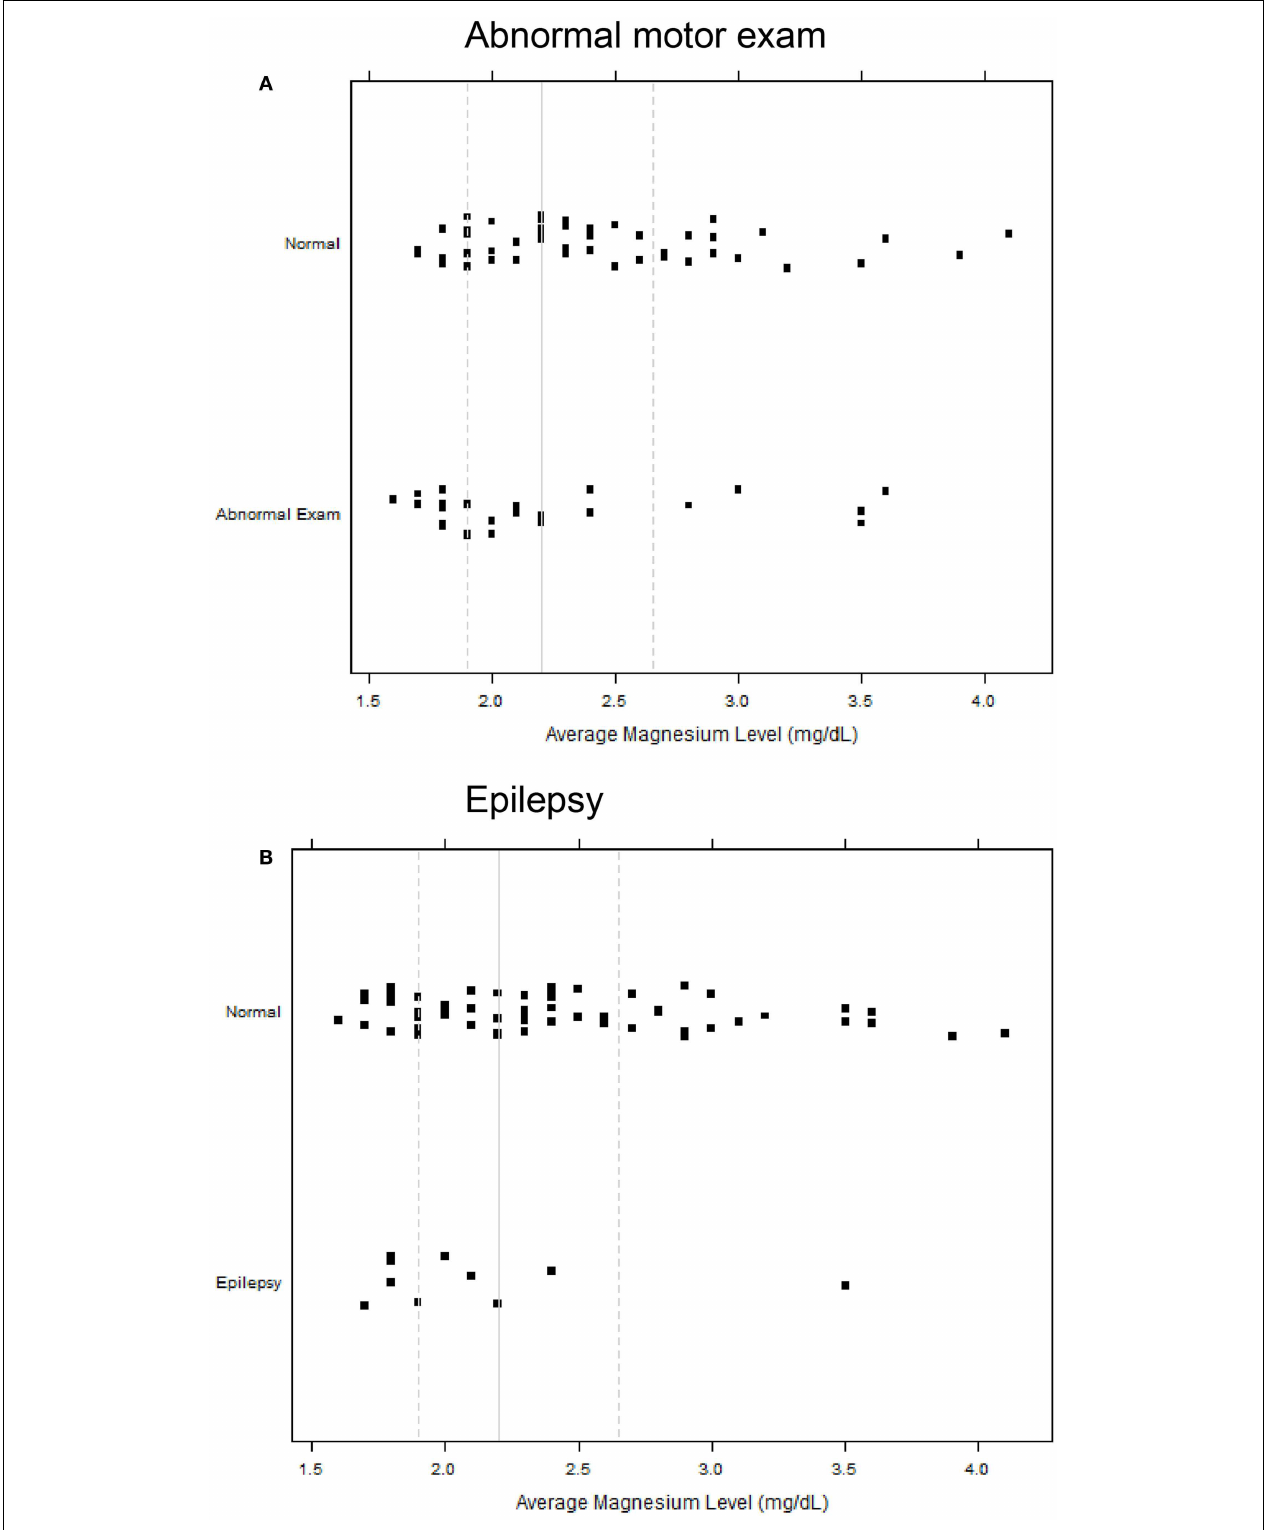
FIGURE 1 | Strip scatterplots of average magnesium levels ( x -axis) and neurodevelopmental outcomes, for abnormal motor exam (A), and epilepsy (B) .Thin line is the median; dotted lines show 25th and 75th quartiles.